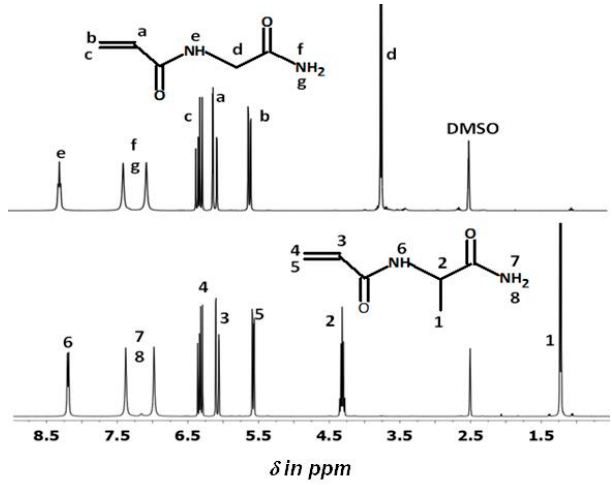
Figure 2. Comparison of the 400 MHz 1 H-NMR spectra of NAGA ( top ) and NA L ALA ( bottom ) in d6-DMSO.